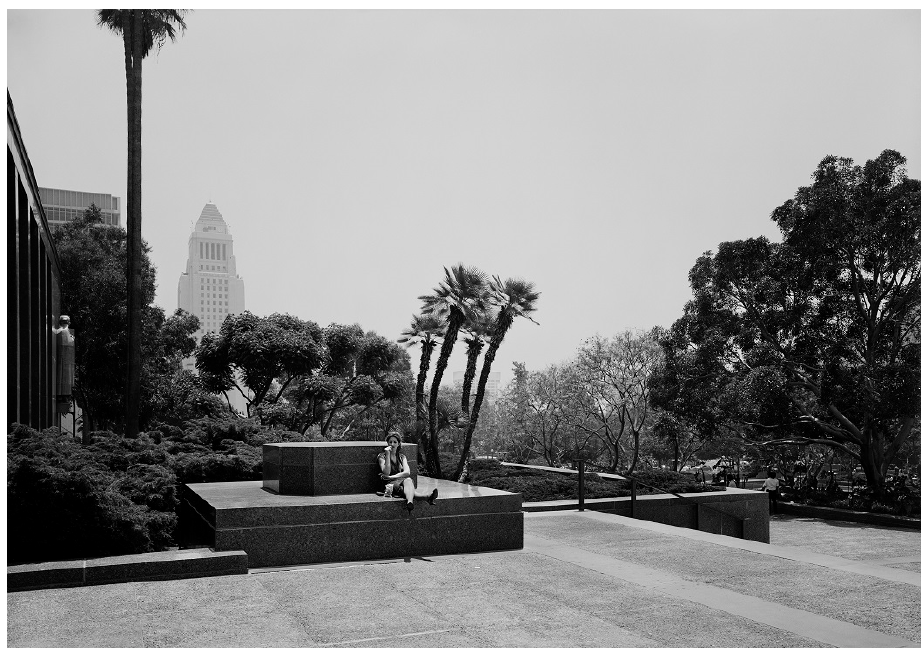
Figure 20. Anthony Hernandez, Public Use Areas #17 (1981), © Anthony Hernandez.